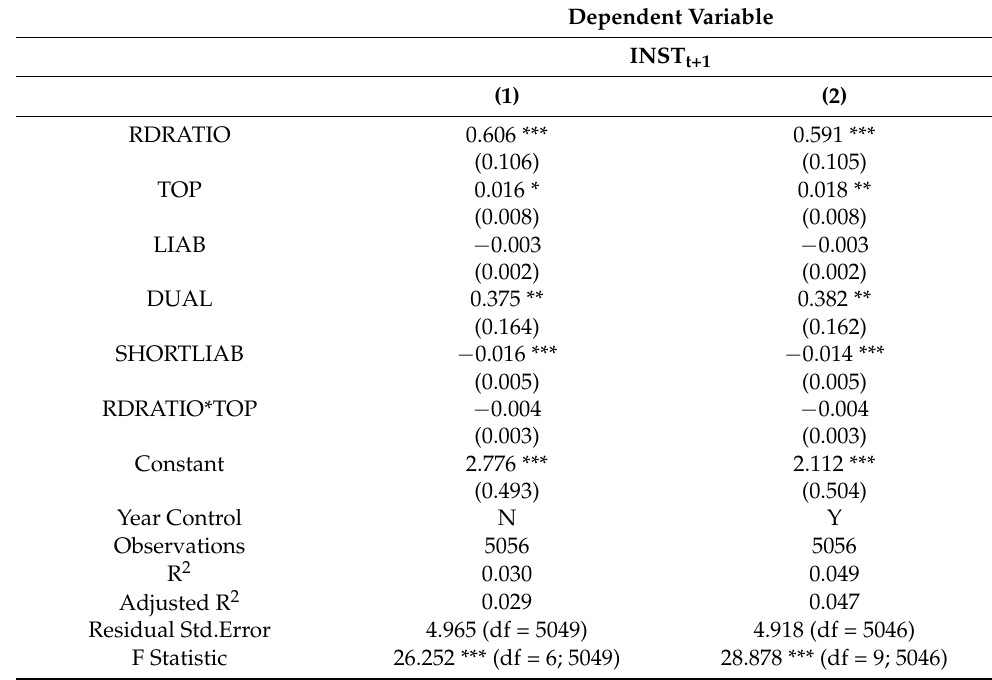
Table 10. Research expense and institutional